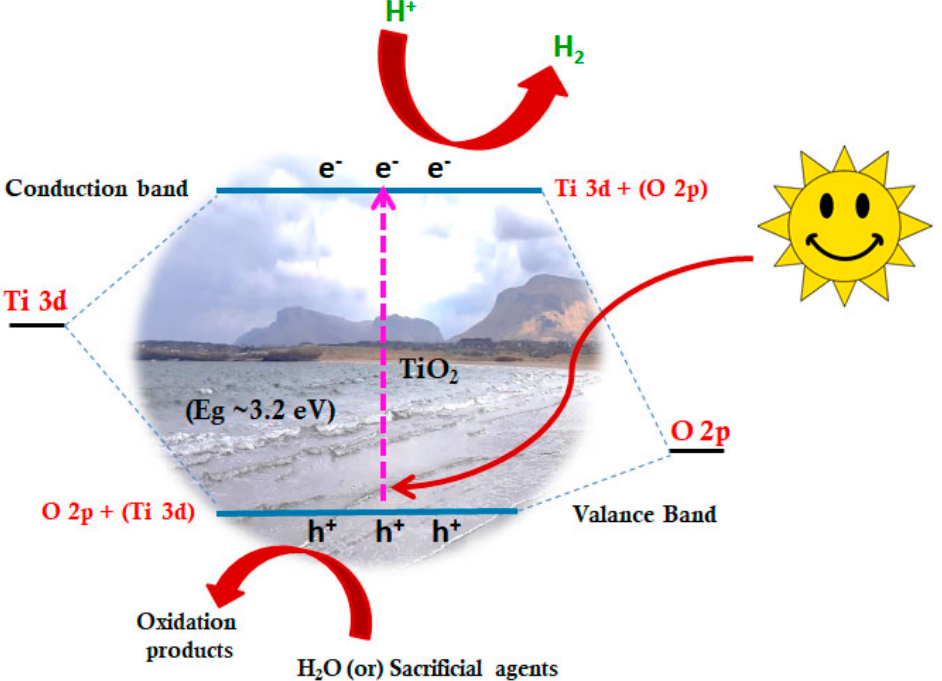
Figure 1. Schematic representation of the water-splitting process on a photocatalyst surface under light irradiation [1]. Reproduced with permission from Ref. [1]. Copyright 2019, Elsevier.